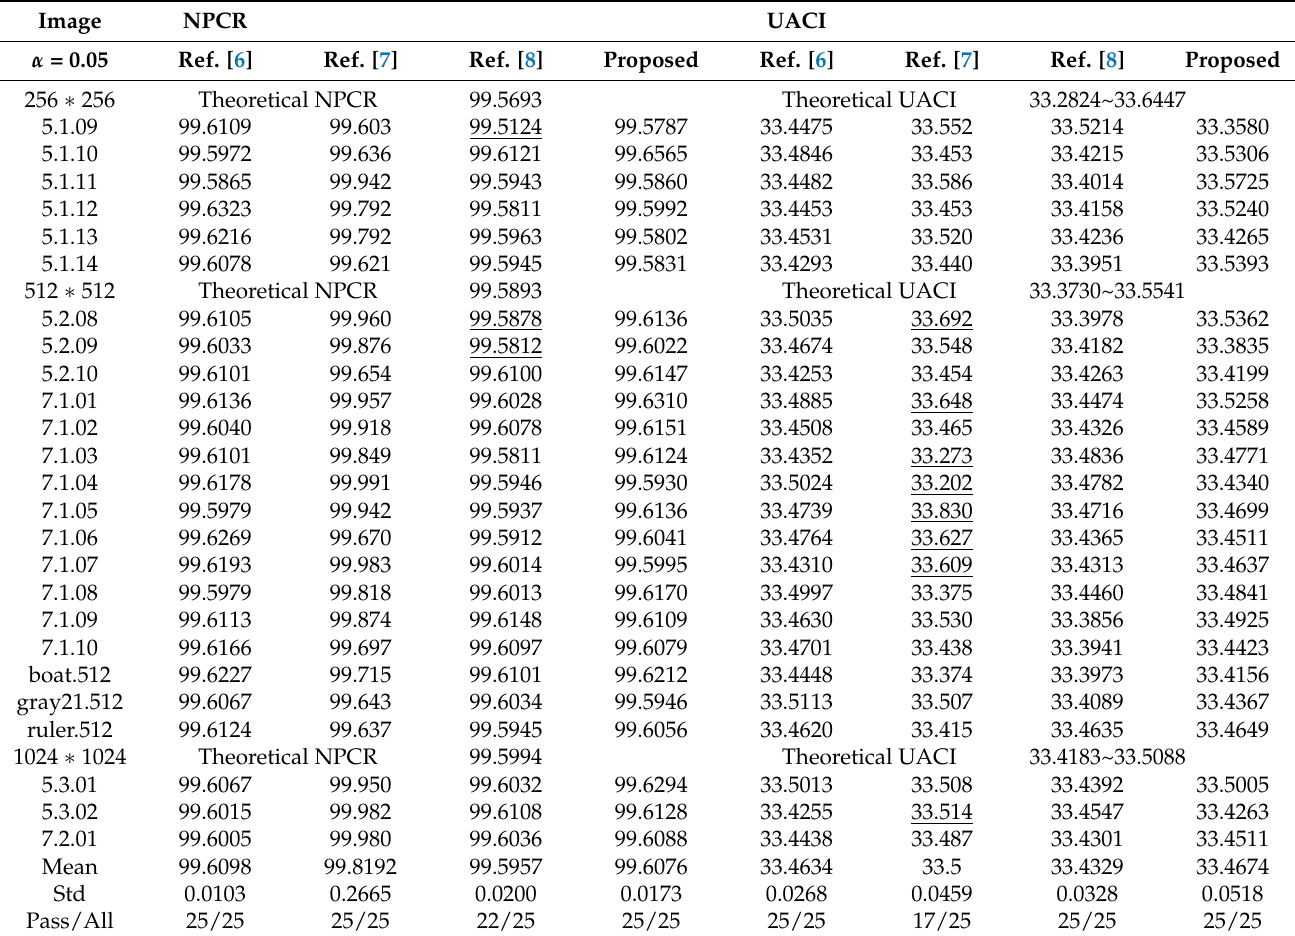
Table 5. NPCR and UACI for different images